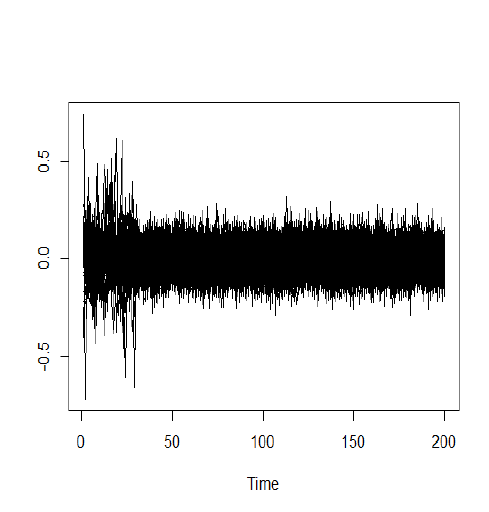
Figure 8: The curves θ i =1, ... ,150 ( t ), t ∈ [0,